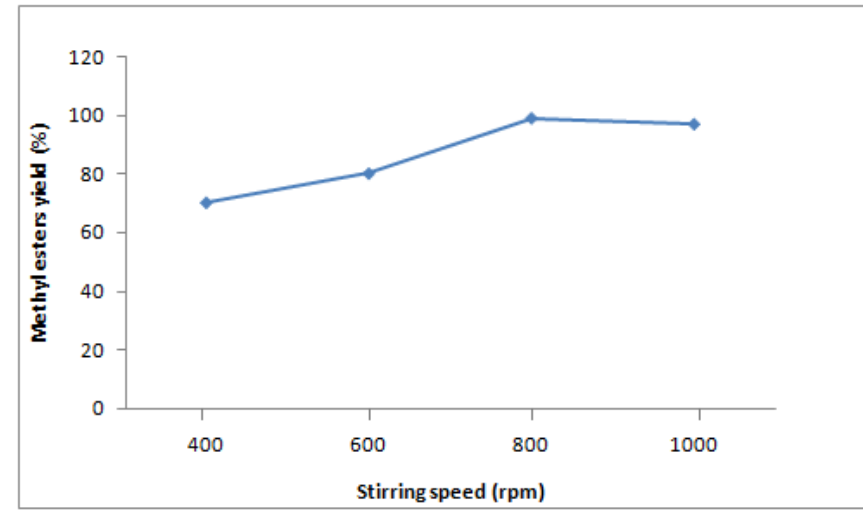
Figure 4. Effect of stirring speed on yield of methyl esters from coconut oil (catalyst concentration 1wt% of oil, molar ratio methanol:oil 7:1, temperature 65°C, flow rate 142 mL/min, residence time 21.04 min).